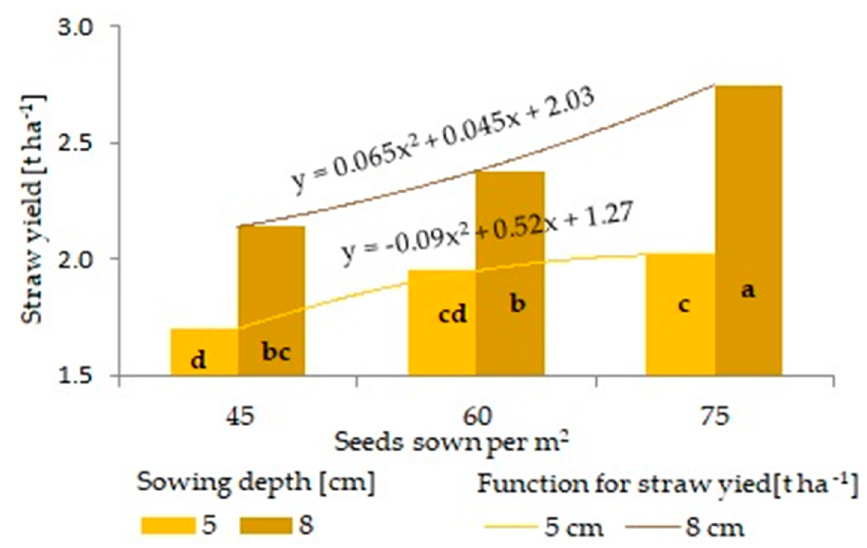
Figure 13. Straw yield in 2013 (SDH× SDY). Different letters indicate significant differences between factors (Tukey’s multiple range test). factors (Tukey’s multiple range